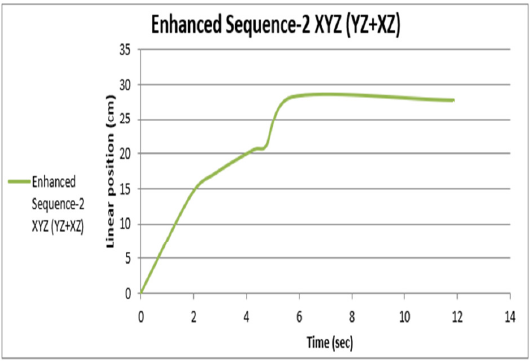
Fig.17. Enhanced sequence XYZ (YZ+XZ) for the second